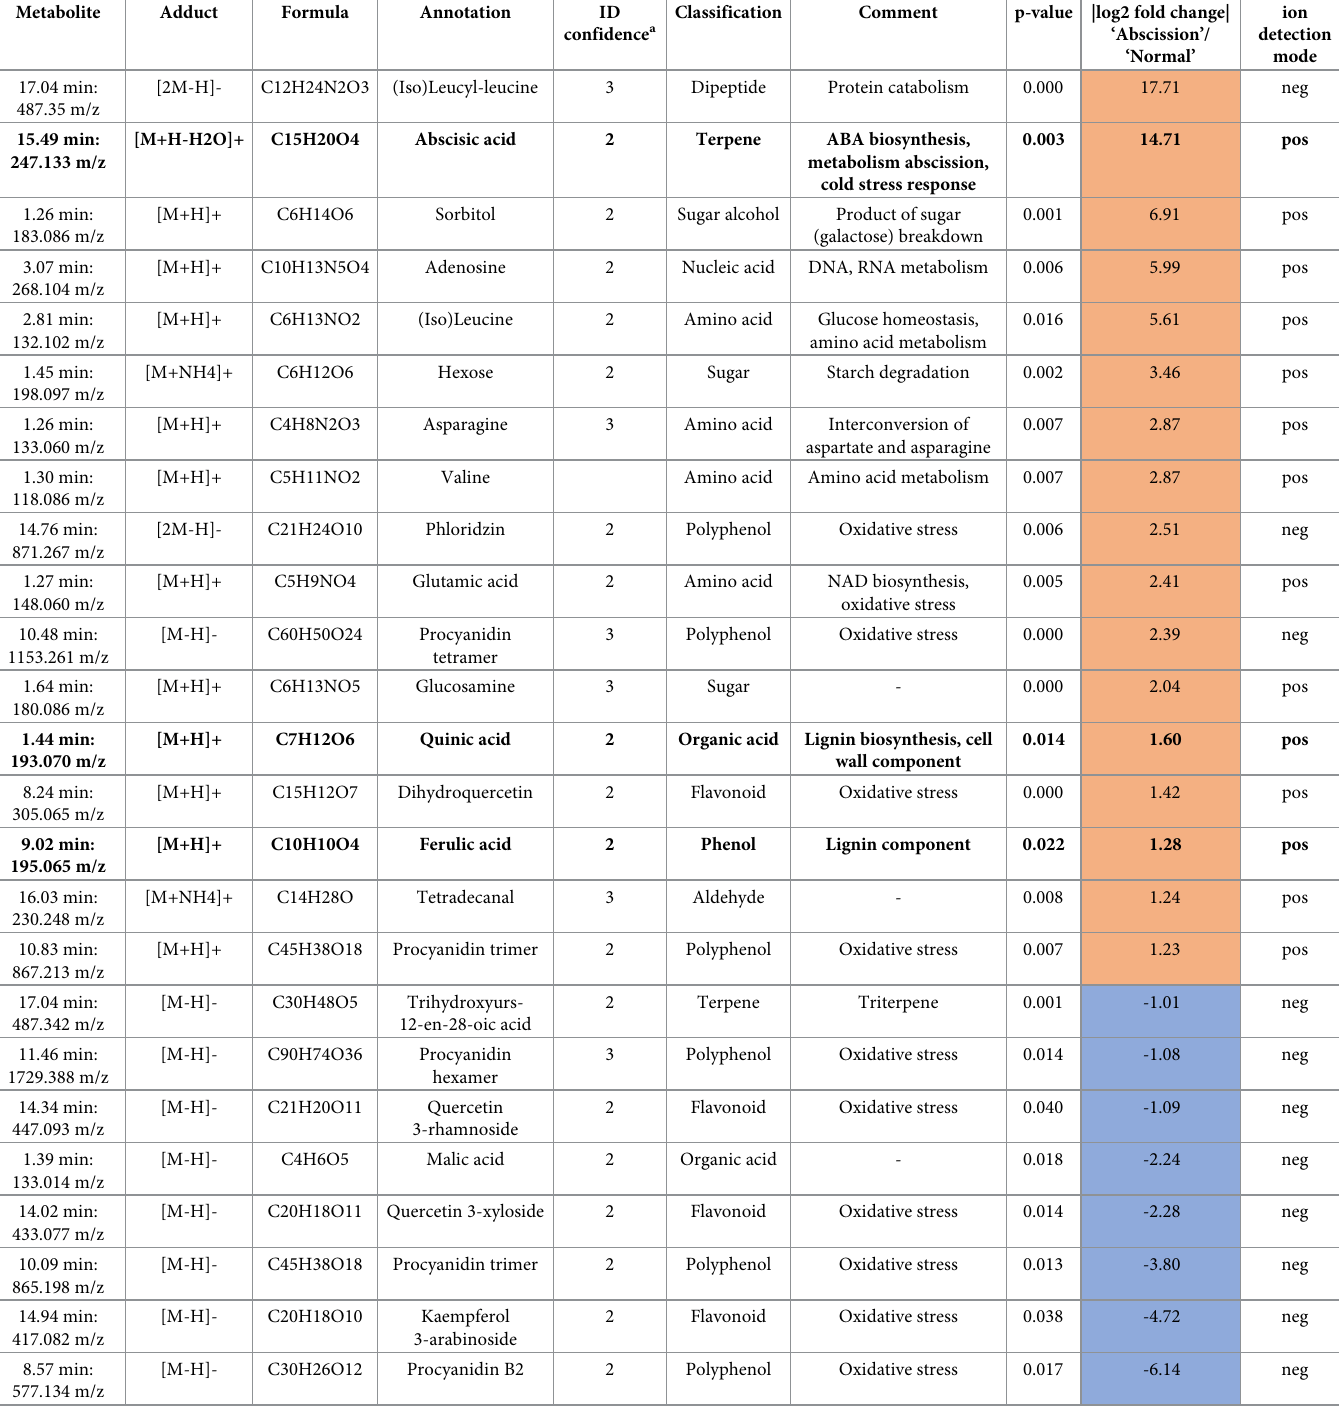
Table 1. Metabolomic profile of young apple fruit/pedicel mixed tissues undergoing